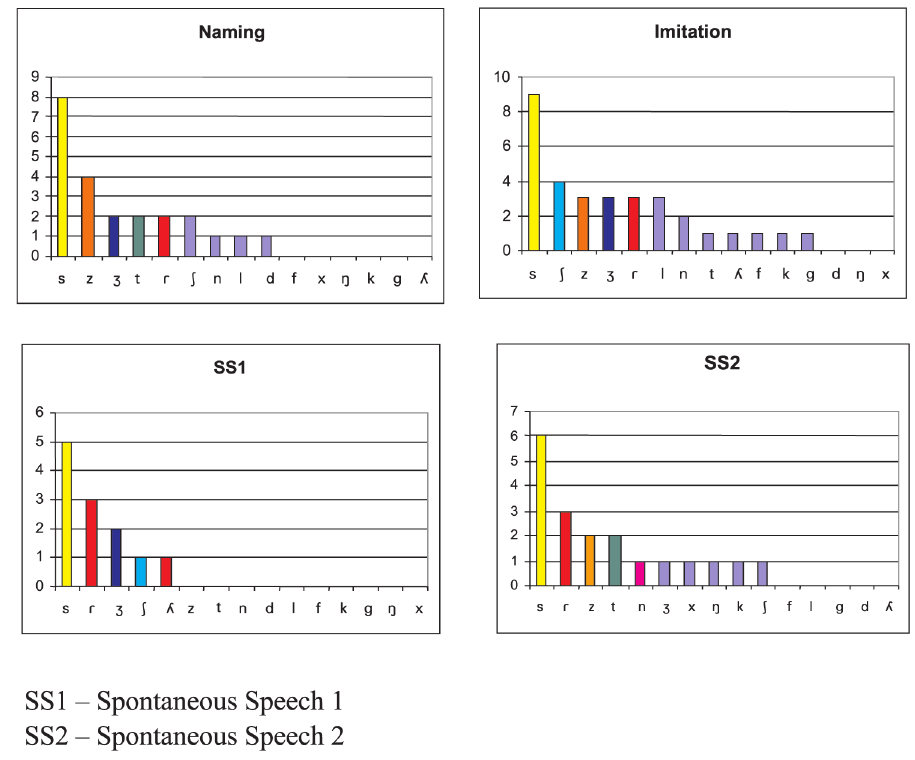
Figure 7 - Occurrence of distortions in the 4 tests in the Group with Phonological